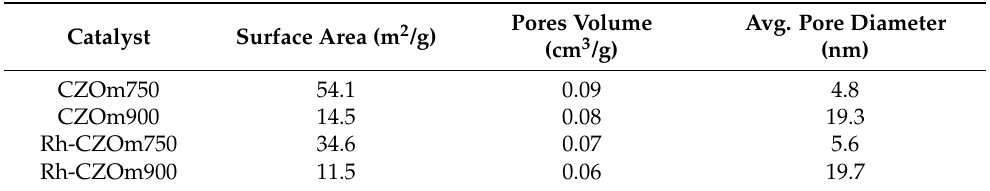
Table 2. Surface area, pore volume and average pore diameter of the CZO samples calcined at 900 (CZOm900) and 750 ◦ C (CZOm750).